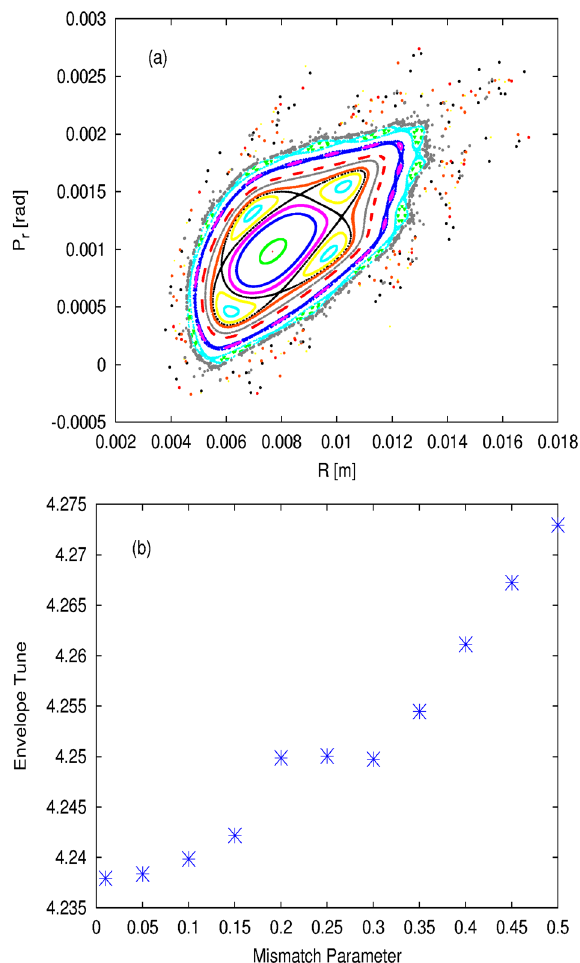
FIG. 7. (Color) (a) Stroboscopic map of the vertical envelope in the PSR lattice for a beam with intensity equal to one-quarter of the full PSR beam intensity listed in Table I. The colors represent varying levels of mismatch. (b) Envelope tune versus the mismatch values used in